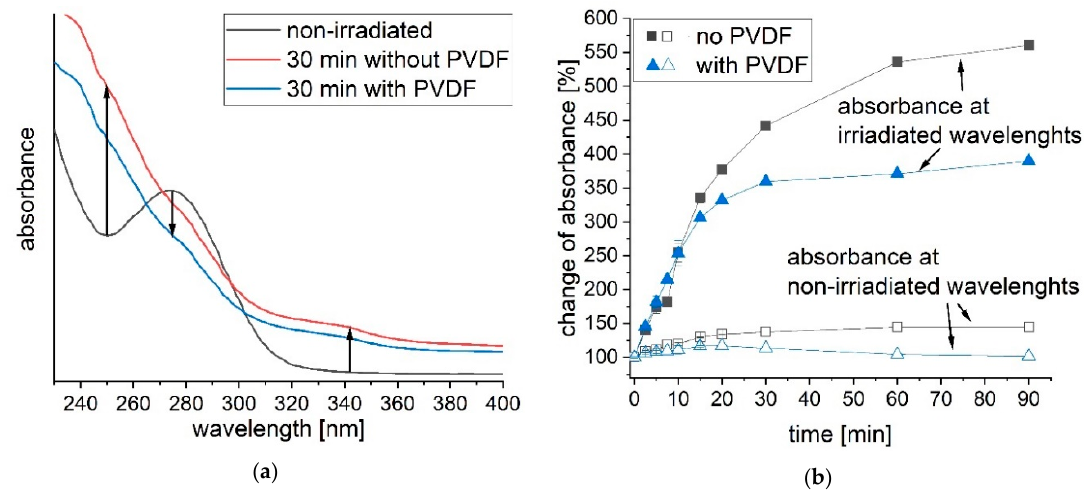
Figure 5. ( a ) Absorbance spectrum of non-irradiated and 30 min UVA irradiated diclofenac with and without PVDF. ( b ) The change of absorbance is shown over time for diclofenac UVA irradiation with and without PVDF. The area under the absorbance vs. wavelength was calculated for the non-irradiated region from 230–309 nm and the irradiated region from 309–400 nm. The change of absorbance was calculated by setting the area of absorbance of the non-irradiated diclofenac solution at 100%.